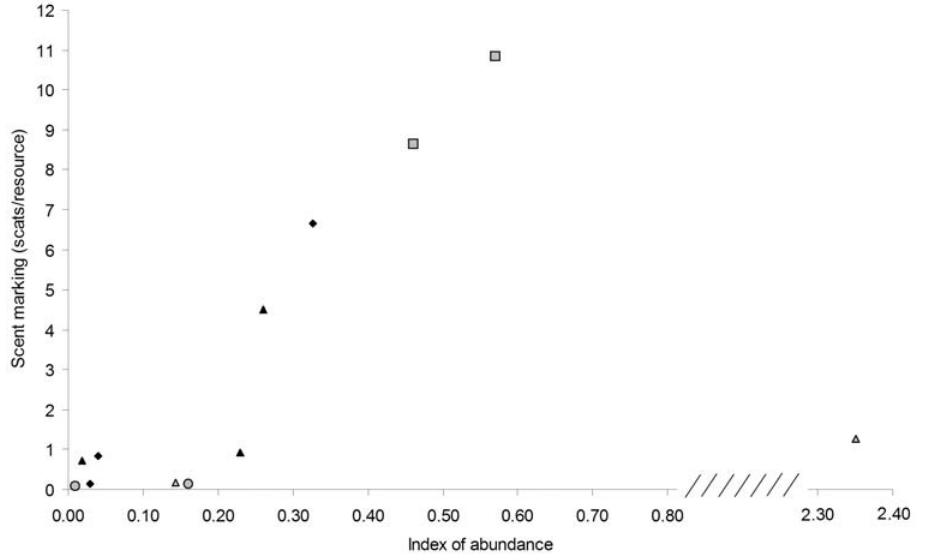
Figure 3. Relation between dingo abundance and scent-marking activity. Black triangles: Red Lake (2006, 2007, 2008), grey triangles: Andamooka (2007, 2008), grey circles: Nantawarrinna (2007, 2008), grey squares: Curdimurka (2007, 2008), and black diamonds represent Pandie Pandie, Mungerannie and the GRNP.